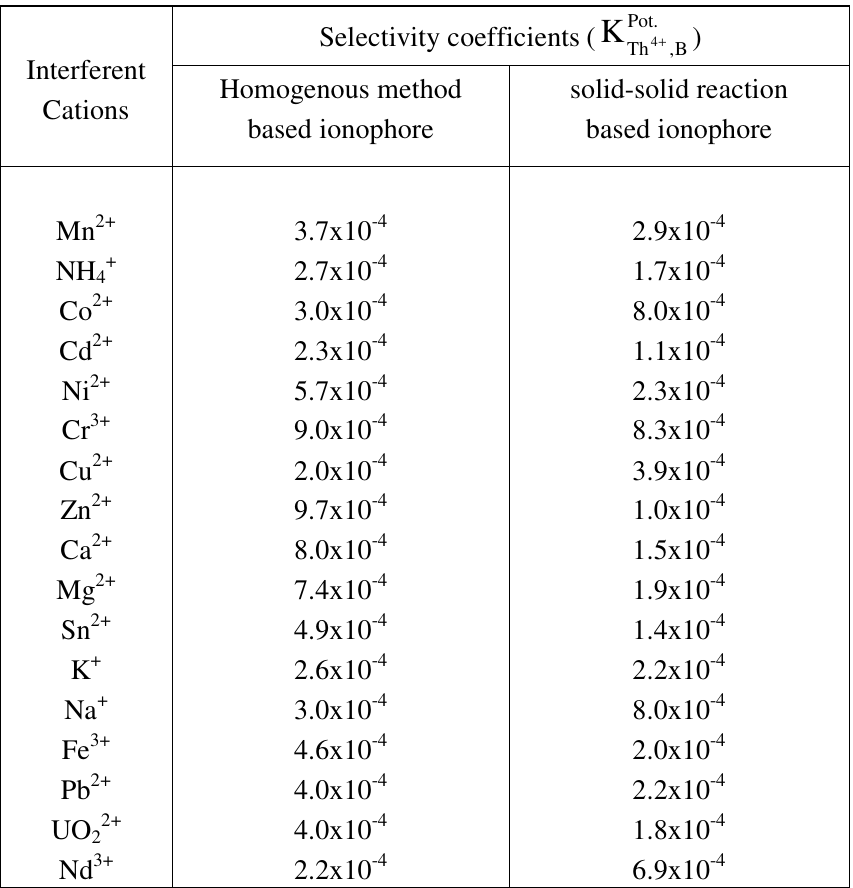
Table 2 Potentiometric selectivity coefficients ( the coated graphite rod based thorium electrode.